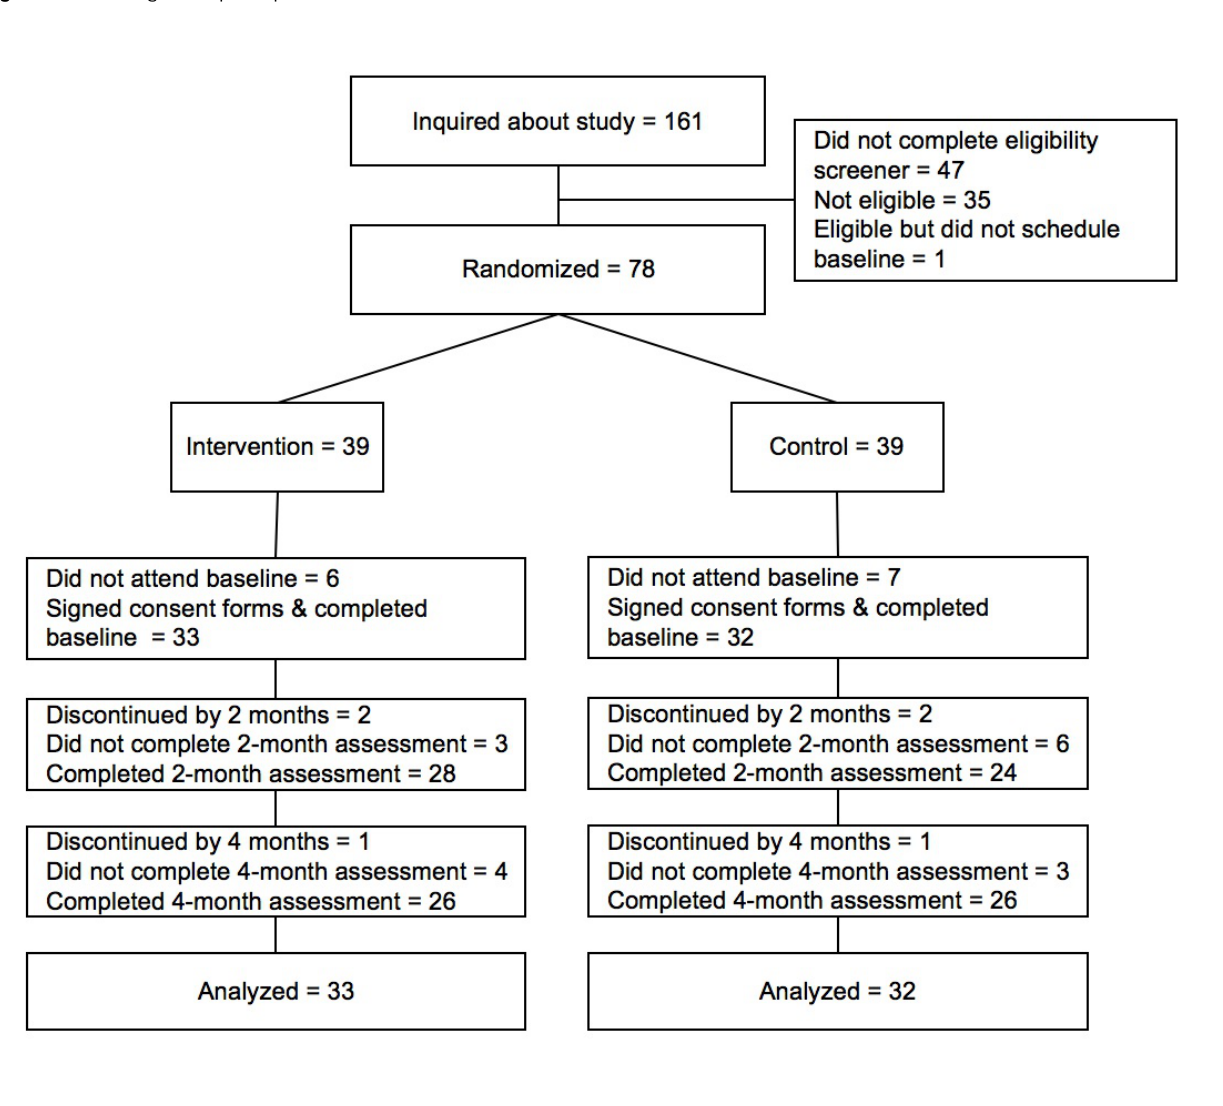
Figure 1. Flow diagram of